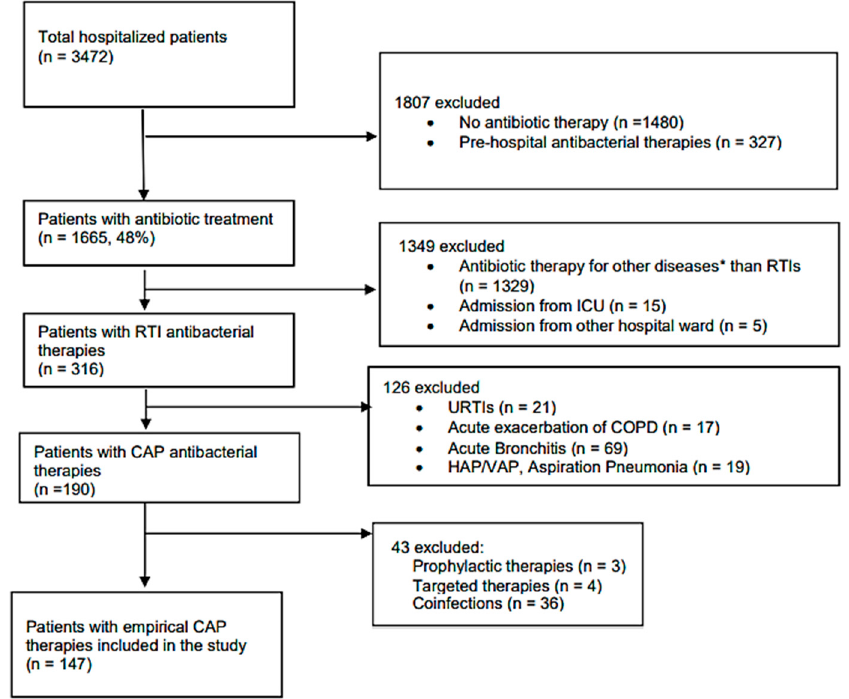
Figure 1. Flowchart for exclusion and inclusion criteria. * Other diseases: e.g., sepsis, urinary tract infection, etc.; RTIs—respiratory tract infections; ICU—intensive care unit; URTIs—upper respira- tory tract infections; COPD—chronic obstructive pulmonary diseases; HAP—hospital acquired pneumonia; VAP—ventilation associated pneumonia; CAP—community acquired pneumonia.